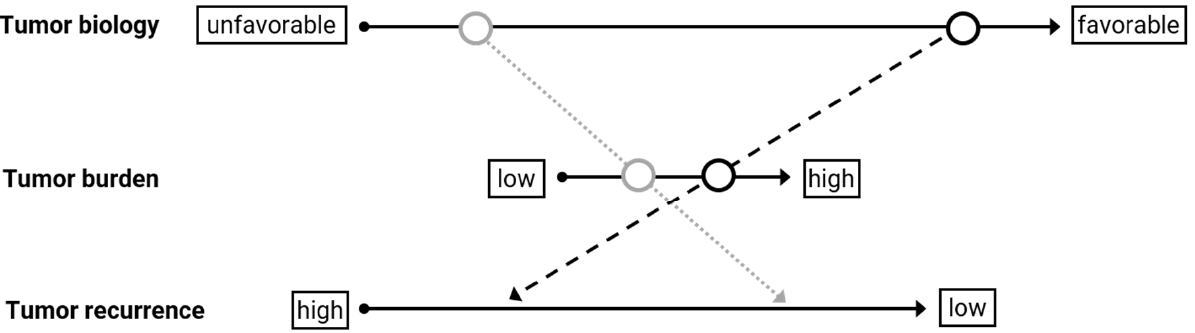
Figure 2. Individual tumor biology, within the limits of technical resectability, is more decisive for the tumor recurrence rate than mere morphometric criteria. Tumors with a low tumor burden but unfavorable tumor biology (arrow in light grey) may have worse outcome as compared to tumors with high tumor burden but favorable tumor biology (arrow in black).